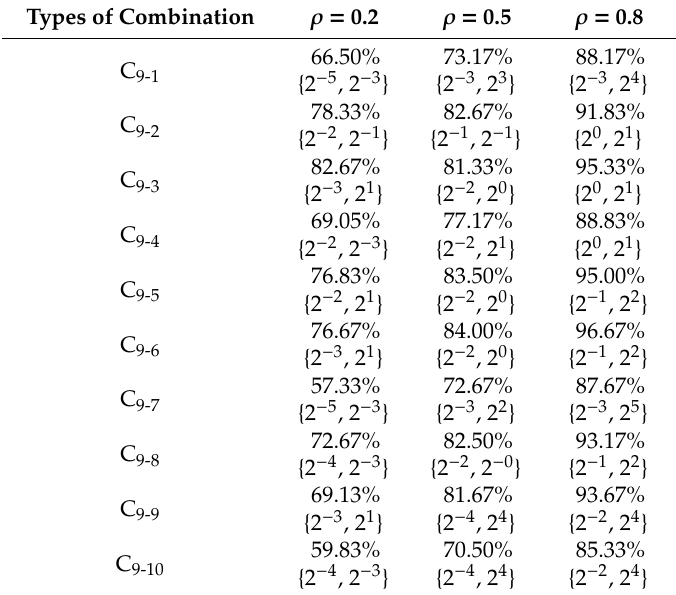
Table 7. SVM Identification results, AIR -SVM {C, γ }, for ten combinations of faults of an MNP 9